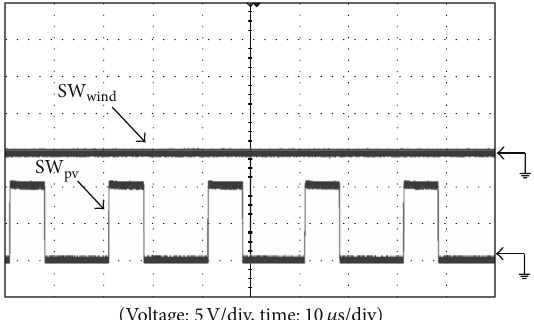
Figure 17: Practical measurements of control signals while PV panel provides 350